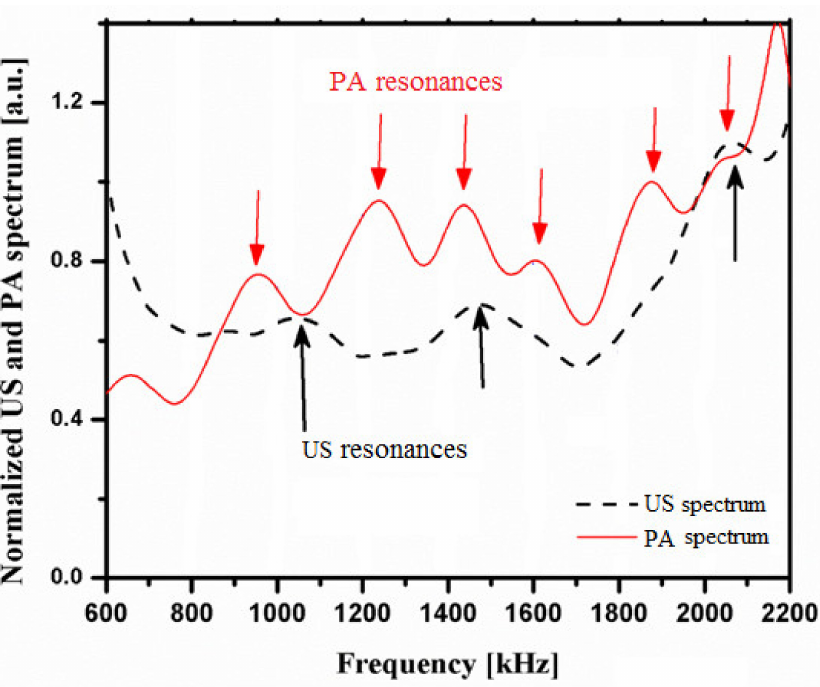
Figure 5. Normalized spectra for US and PA signals vs. source frequency with 1 × inter-trabeculae distance bone samples.